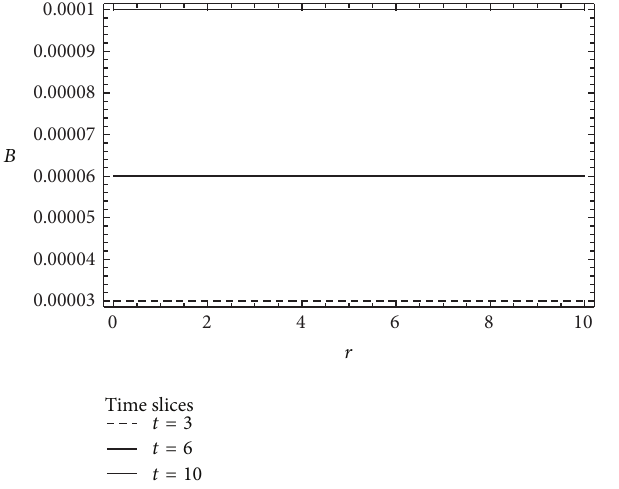
Figure 2: The potential 𝐵 versus 𝑟 at varying units of time.